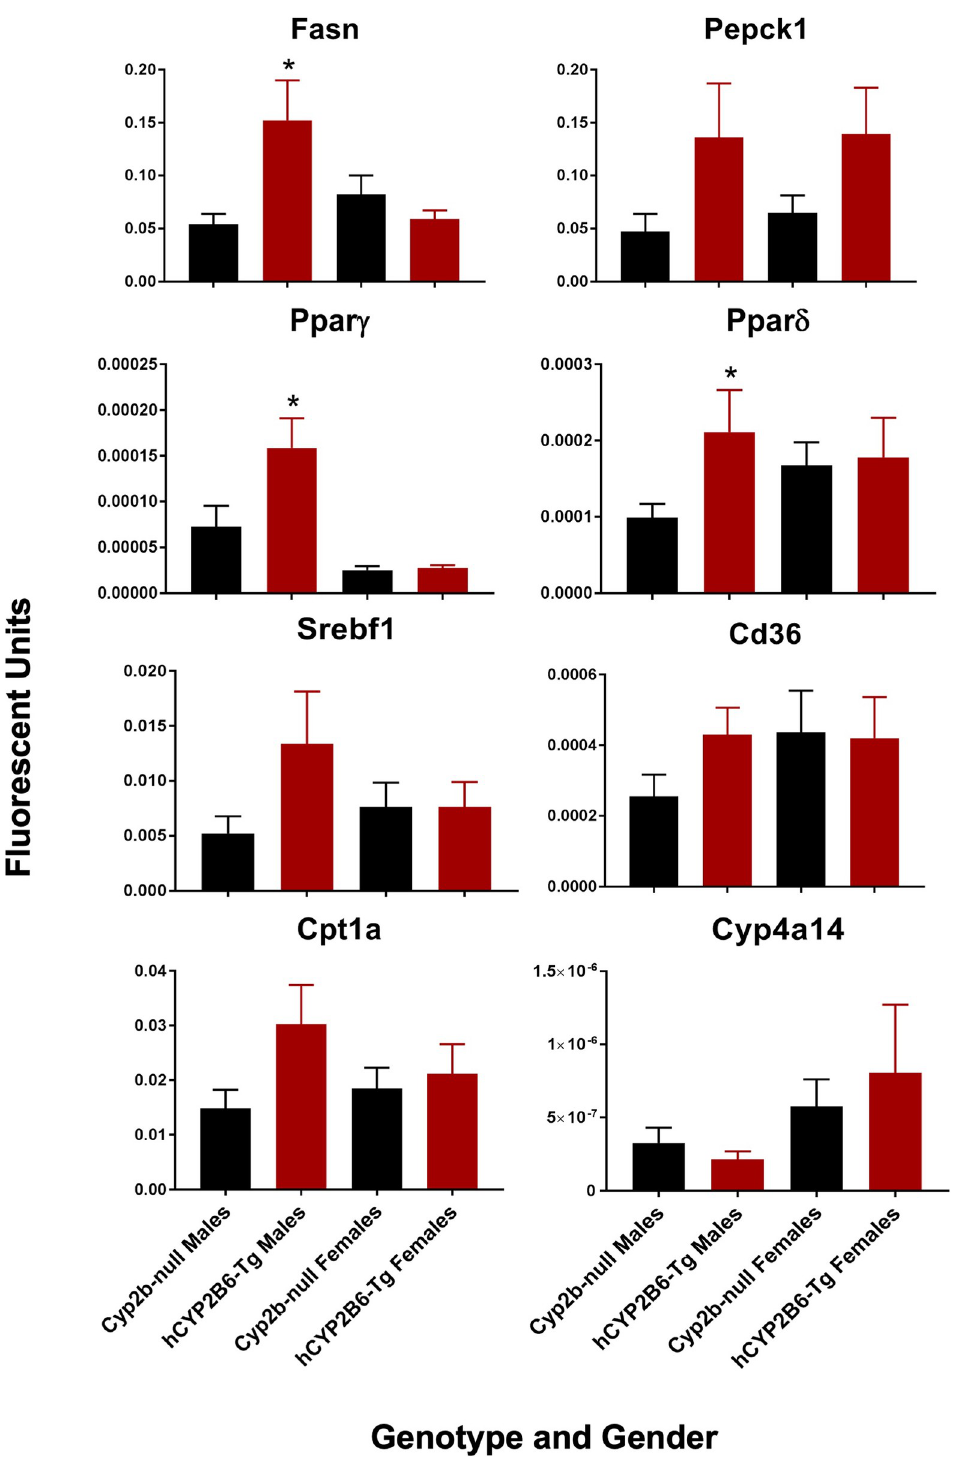
Fig 9. qPCR confirms changes in gene expression of energy metabolism genes regulated by PPAR γ in males. Data are presented as mean + SEM. Statistical significance was determinedy by ANOVA followed by Fisher’s LSD as the post-hoc test (n = 5). � indicates a p-value <